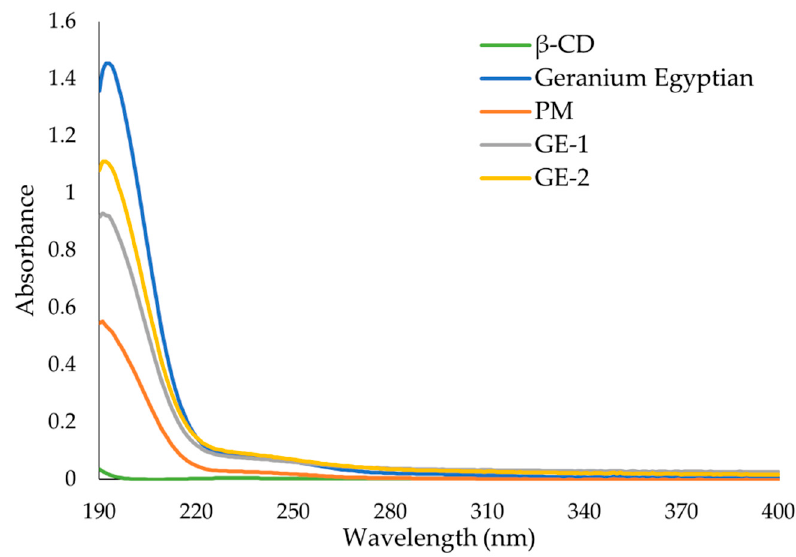
Figure 10. UV-Vis spectra of β -cyclodextrin ( β -CD), geranium Egyptian (GE) essential oil, physical mixture of both (PM) and inclusion complexes GE-1 and GE-2. Solutions were prepared in water and have the same β -CD or essential oil concentration where applicable.